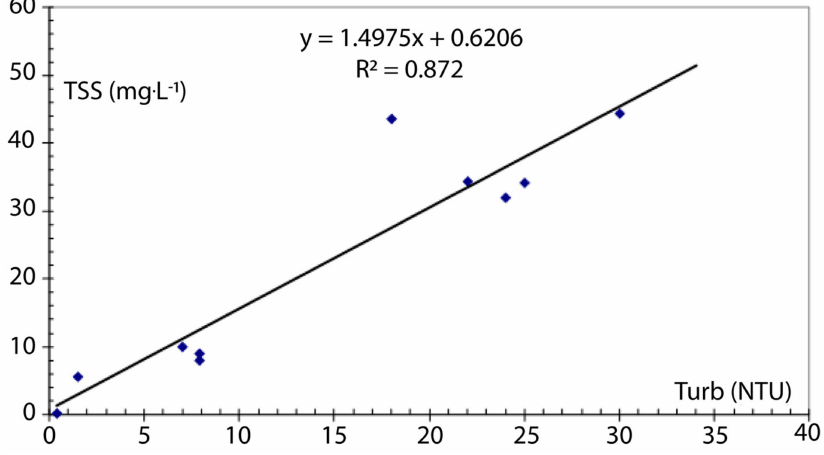
Figure 8. Relation between TSS (mg · L − 1 ) and turbidity (NTU) for the Casiquiare